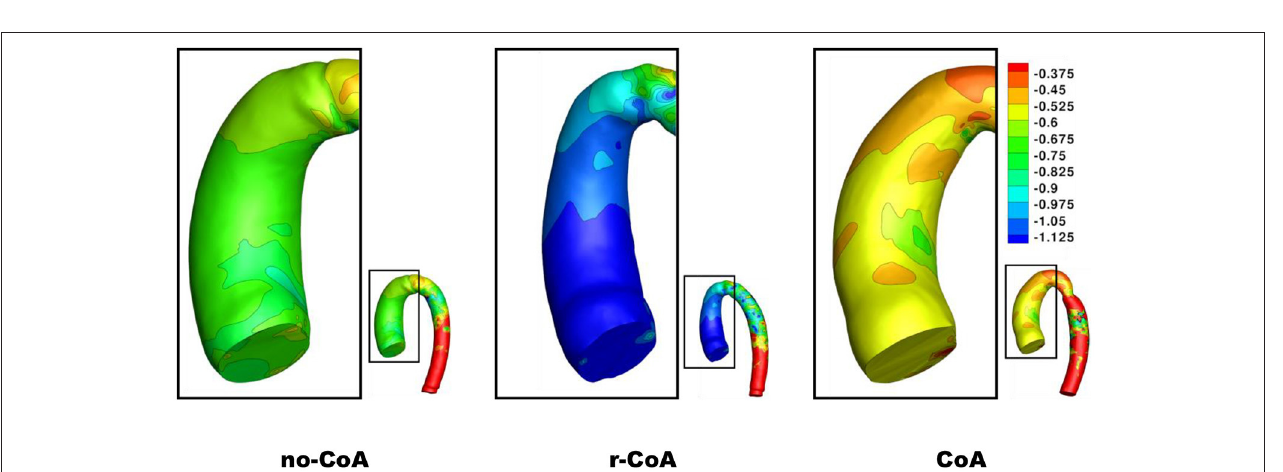
Frontiers in Cardiovascular Medicine |